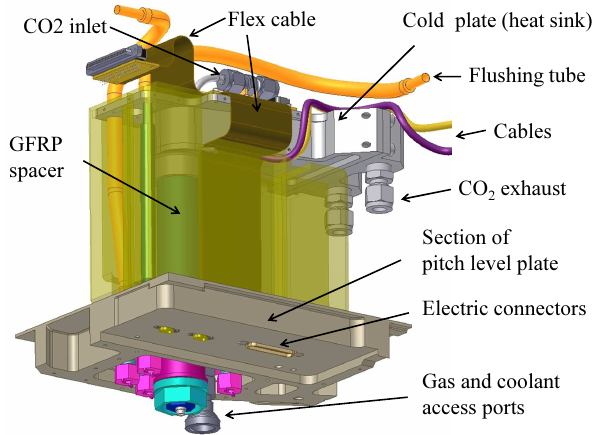
Figure 4. The insulation feedthrough assembly mounted on the pitch level plate (partly shown in gray). The heat input by tubes and cables between bottom part (ambient temperature) and top part (optic working temperature) is minimized.